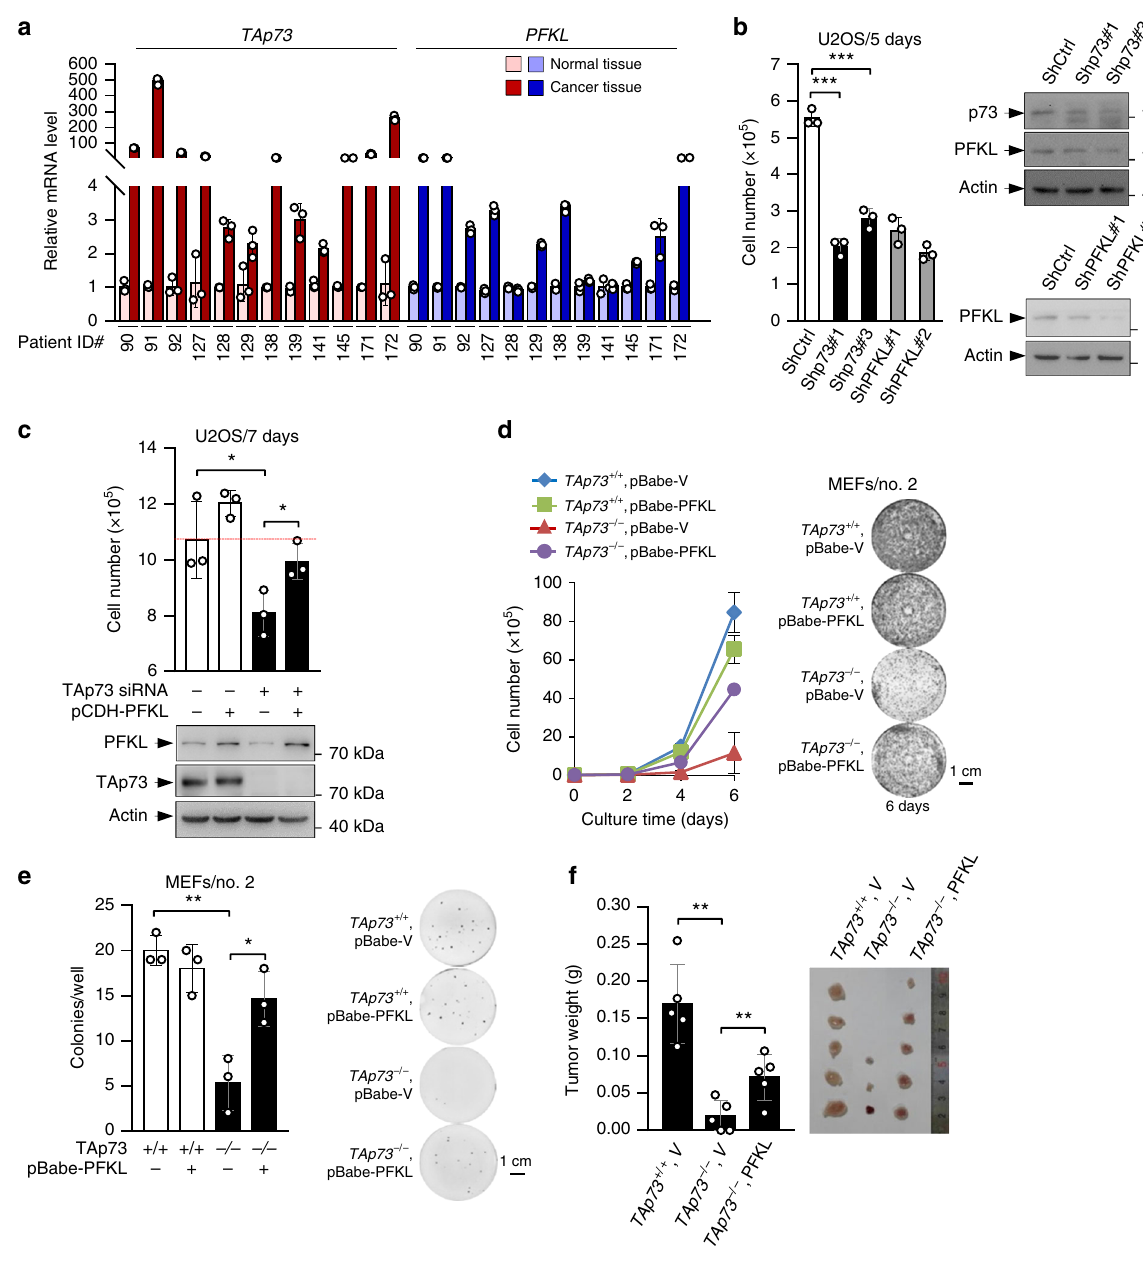
Fig. 6 TAp73 promotes tumorigenesis through PFKL. a Expressions of TAp73 and PFKL in human colon tumors (C) and normal colon tissues (N) were analyzed by qRT-PCR. Patient ID numbers are shown. b U2OS cells stably expressing control or each of the two independent shRNAs for p73 or PFKL shRNA were analyzed for proliferation (left) and protein expression (right, means ± S.D., n = 3). c U2OS cells stably expressing control vector or PFKL were treated with or without TAp73 siRNA. Proliferation (top), and protein expression (bottom) were assayed. Experiments were repeated at least three times. d Proliferation of TAp73 + / + and TAp73 − / − MEF cells stably expressing PFKL or vector control (left, means± S.D., n = 3), and representative images of cells stained with crystal violet at day 6 (right). e Left: Colony formation assay of TAp73 + / + and TAp73 − / − MEF cells stably expressing PFKL or vector control. Numbers of colonies with a diameter greater than 20 μ m were quanti fi ed (means ± S.D., n = 3). Right: Representative images of colonies stained with crystal violet at day 6. f Average weights (left) and images (right) of xenograft tumors (3 weeks, means ± S.D., n = 5) generated by TAp73 + / + and TAp73 − / − MEF cells stably expressing PFKL or vector control as